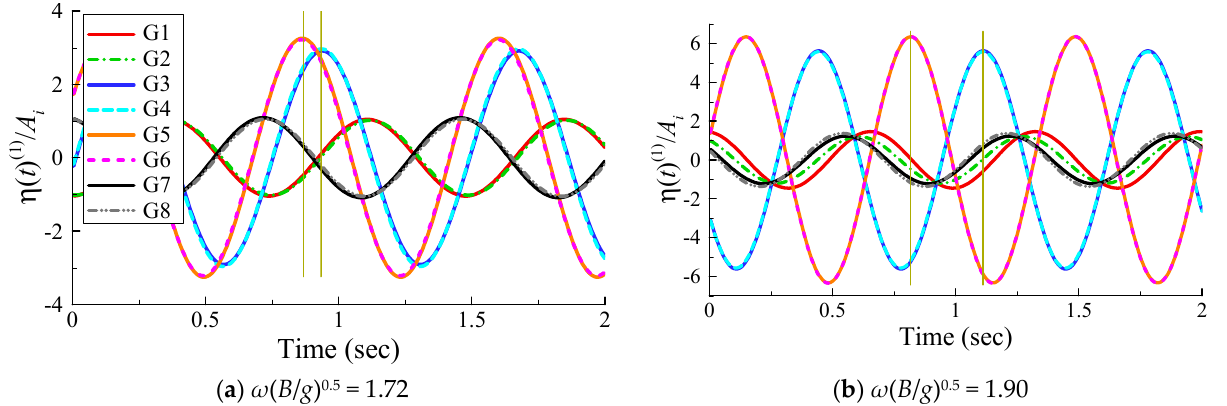
Figure 10. Time histories of the free-surface responses at G1 ~ G8 based on linear frequency-domain solutions.